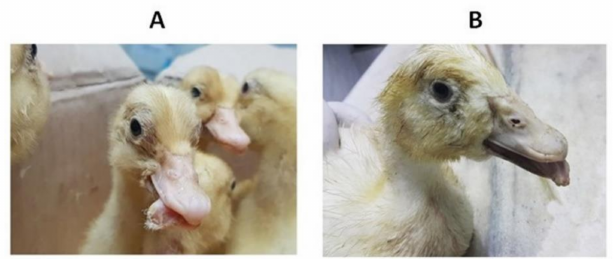
Figure 1. Characteristic signs of short beaks and protruded tongues in Pekin ducks ( A ) and mule ducks ( B ).